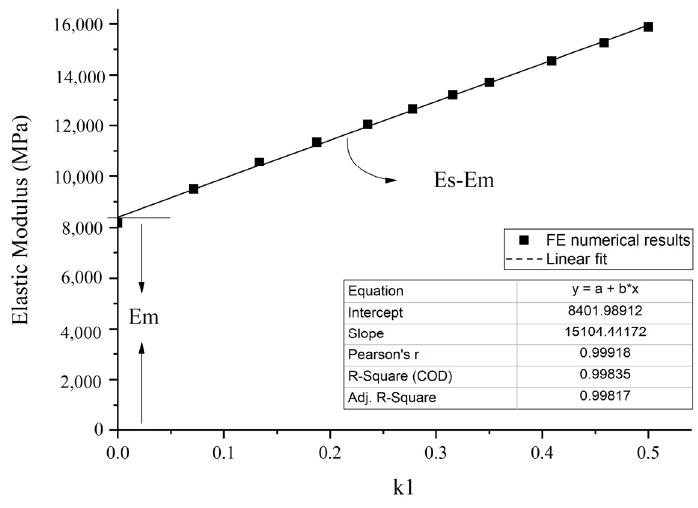
Figure 14. Comparison of elastics modulus from experimentation, FE numerical, estimation formula versus k1.